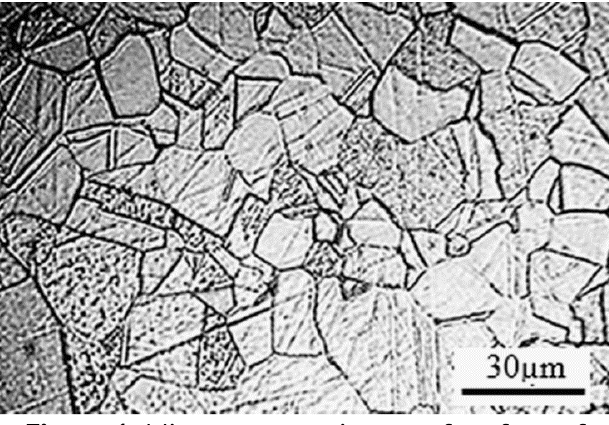
Figure 1 . Microstructure image of surface of AISI 316L austenitic stainless steel after chemical